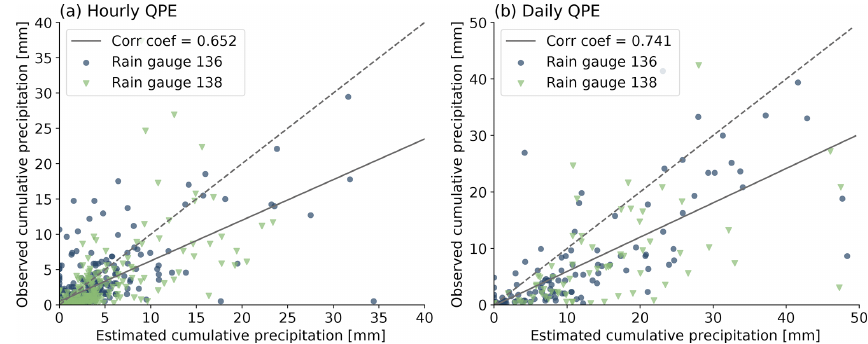
Figure 2. (a) Scatter plot showing the relationship between the hourly cumulative precipitation estimated using the QPE technique and the in situ precipitation from the postevent SIATA rain gauges. The dashed line corresponds to a hypothetical perfect adjustment and the continuous line to the actual linear fit between the QPE technique and the in situ precipitation. (b) Similar to (a) but for daily cumulative